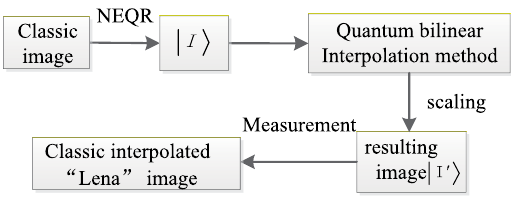
Figure 24. The concrete procedure of quantum bilinear interpolation